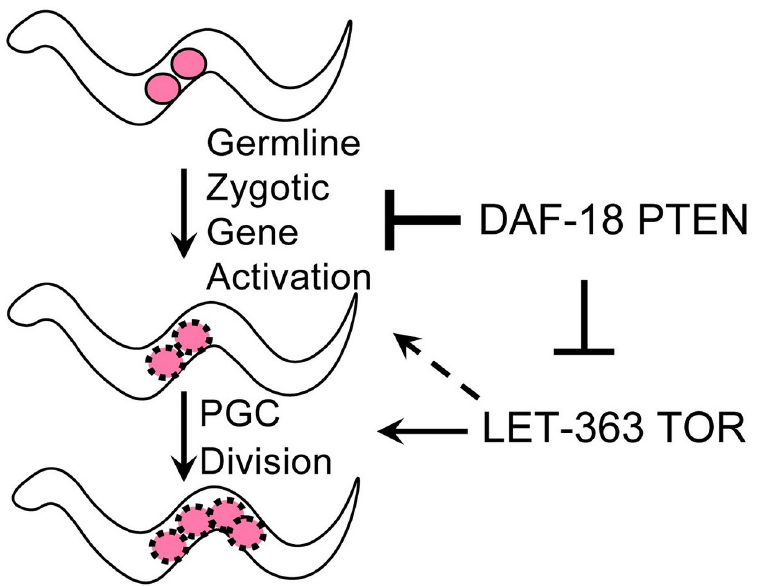
Fig 7. Model for DAF-18-mediated regulation of arrested PGCs in L1 starvation conditions. In the absence of food, DAF-18 represses germline zygotic gene activation, partially independent of its canonical negative regulation of PI3K-TOR that regulates PGC division. See text for